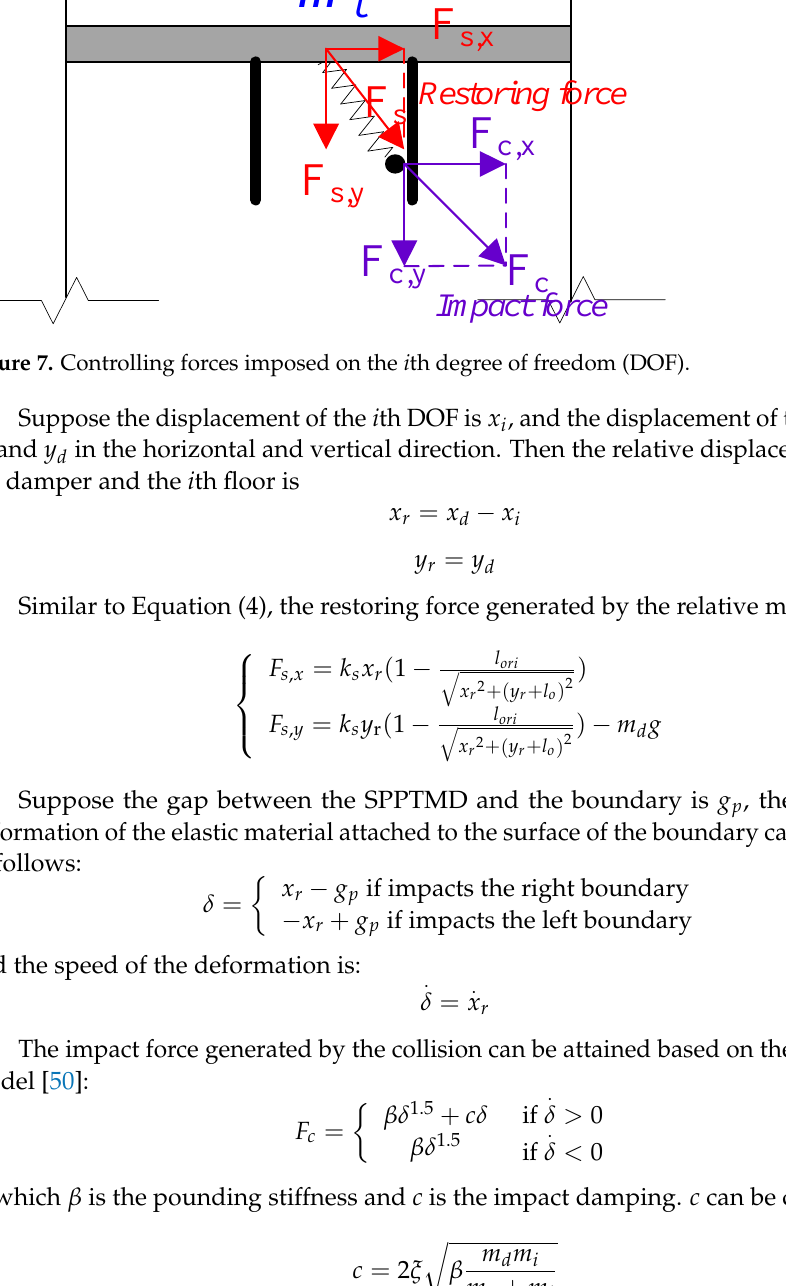
Figure 6. Schematic of the structure-SPPTMD system.